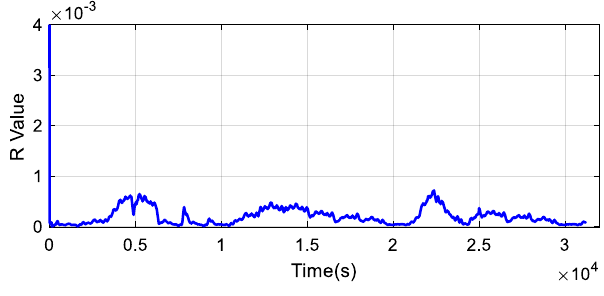
Figure 13. R value of AUKF algorithm.